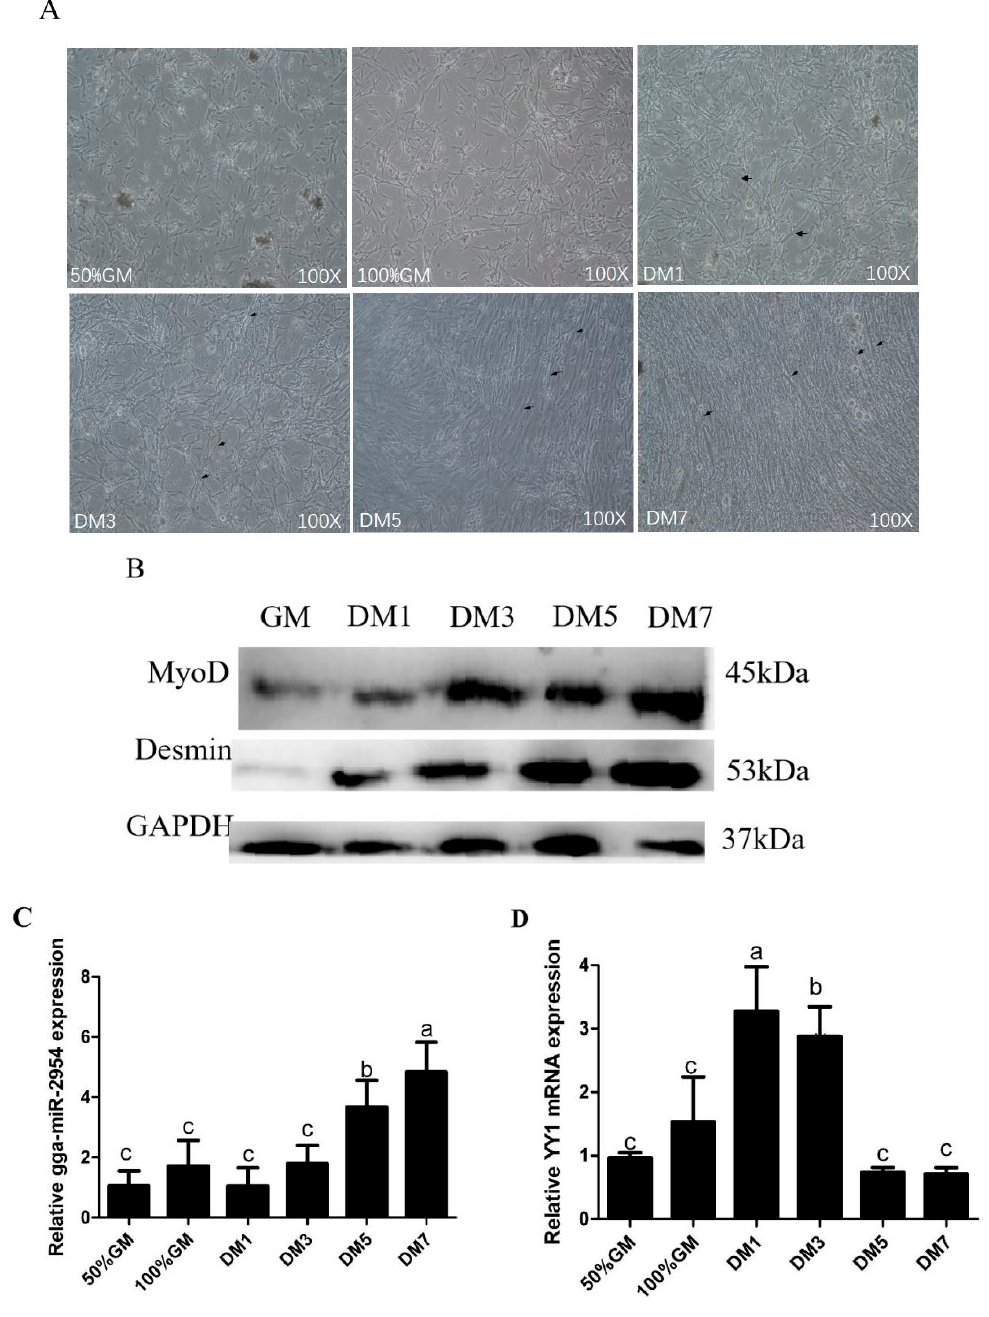
Figure 2. The expression of gga-miR-2954 and YY1 during chicken primary myoblast differentiation. ( A ) The morphological map of chicken primary myoblasts during proliferation (50% and 100% growth density, 50% GM and 100% GM) and differentiation from the 1st to 7th day (DM1 to DM7). Black arrow indicates the myotube. ( B ) The protein expression of MyoD and Desmin. ( C ) Q-PCR analysis of gga-miR-2954 expression in myogenesis in vitro. ( D ) The mRNA expression of YY1 . All measurements shown were the means ± SEM from at least three independent experiments, and the different lower-case letter indicates significant difference, p value <